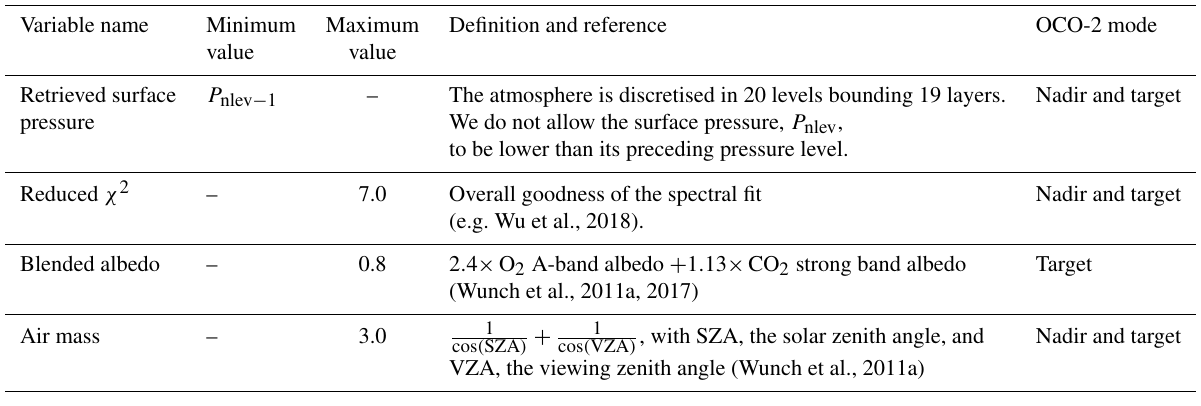
Table 3. Filters applied on 5AI retrieval results for this work.